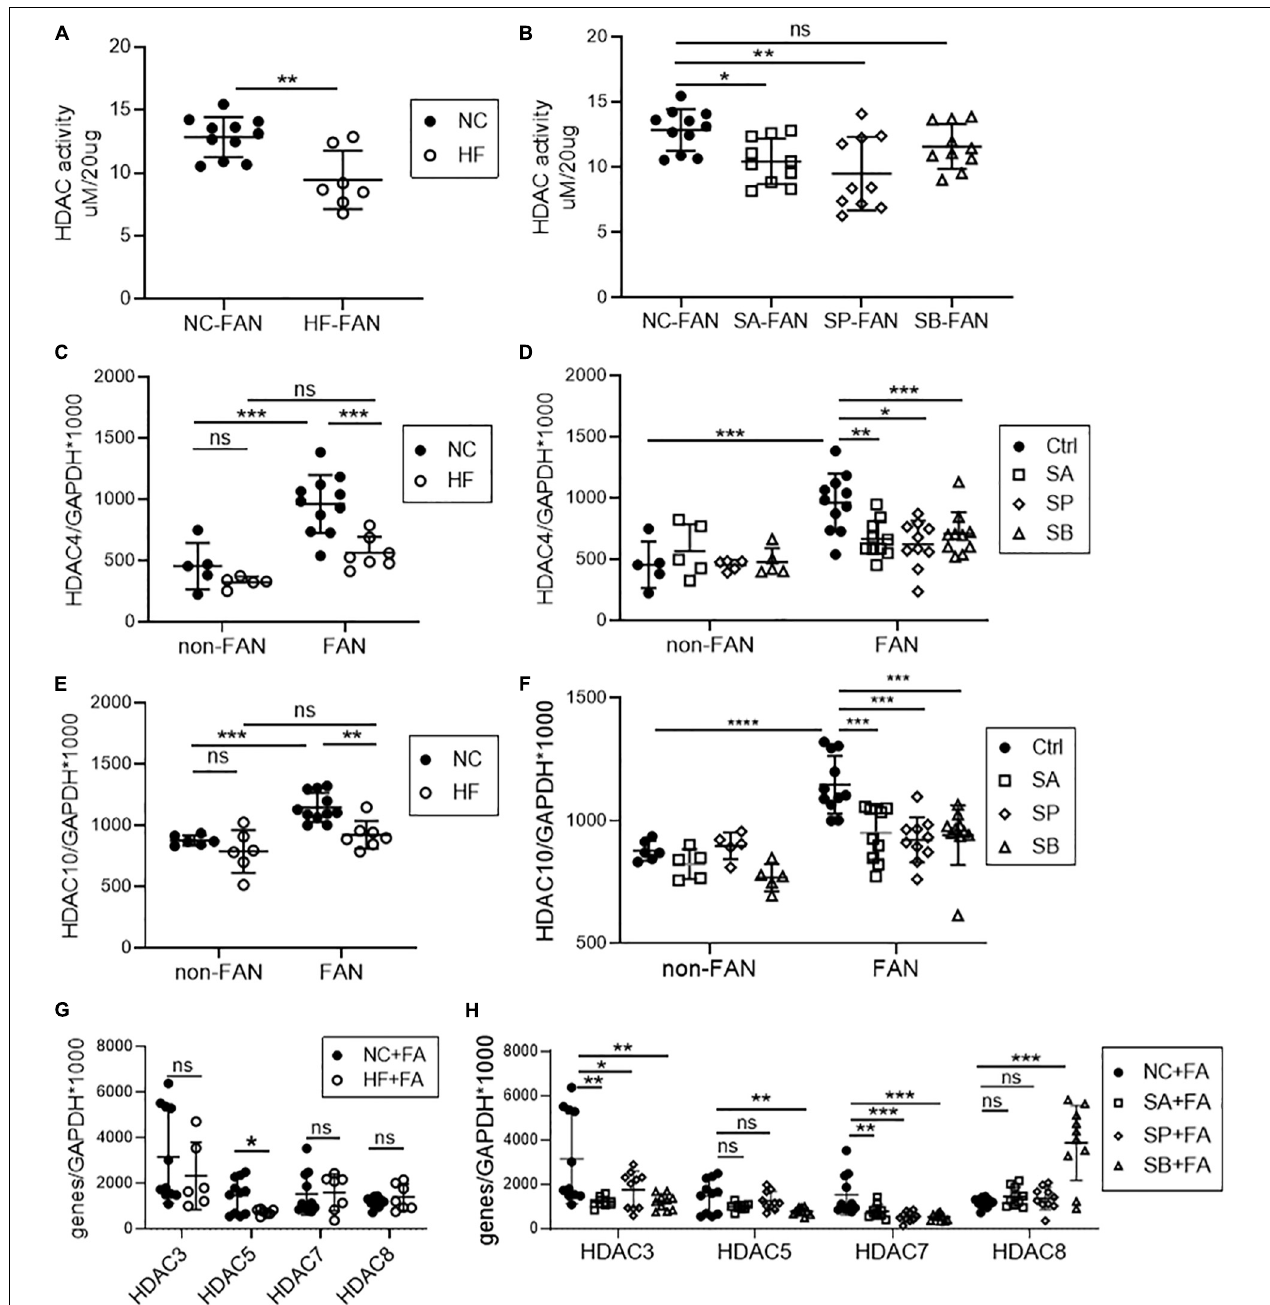
FIGURE 8 | HF and SCFA are involved in epigenetic modification through downregulation of HDAC expression. Downregulation of kidney histone deacetylase (HDAC) activity was seen in HF fed (A) , acetate and propionate treated FAN mice (B) compared to controls at day 2. (C–H) mRNA expression of HDAC subclasses in FAN kidneys. HF diet (C,E) and all three SCFAs (D,F) reduced kidney mRNA expression of HDAC4 and HDAC10 respectively in FAN. FAN ( n = 10); non-FAN ( n = 5). Data are shown as means ± SEM; * P < 0.05, ** P < 0.01, *** P < 0.001, **** P <